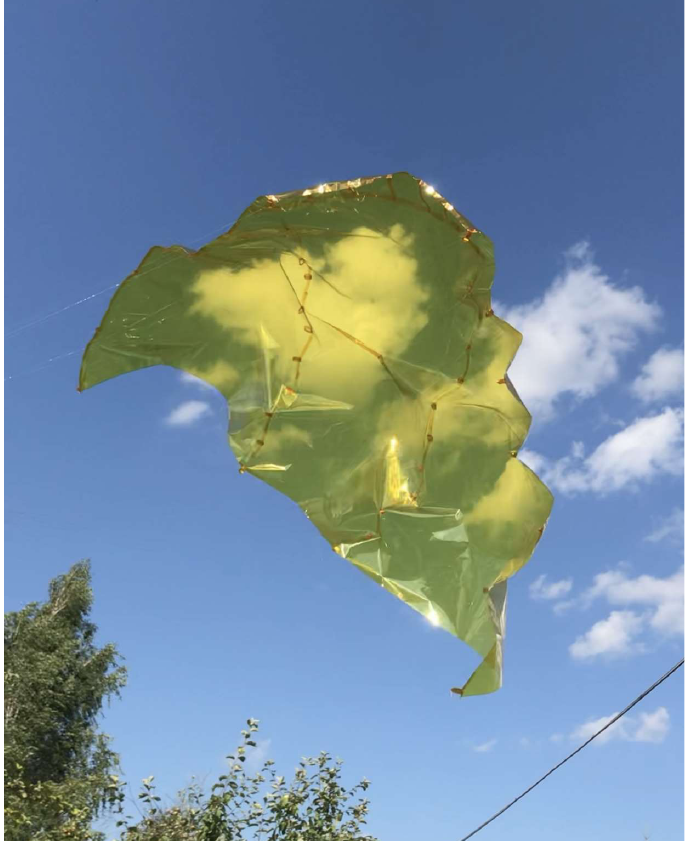
Figure 12. Prototype Kapton wing being flight-tested as a kite.